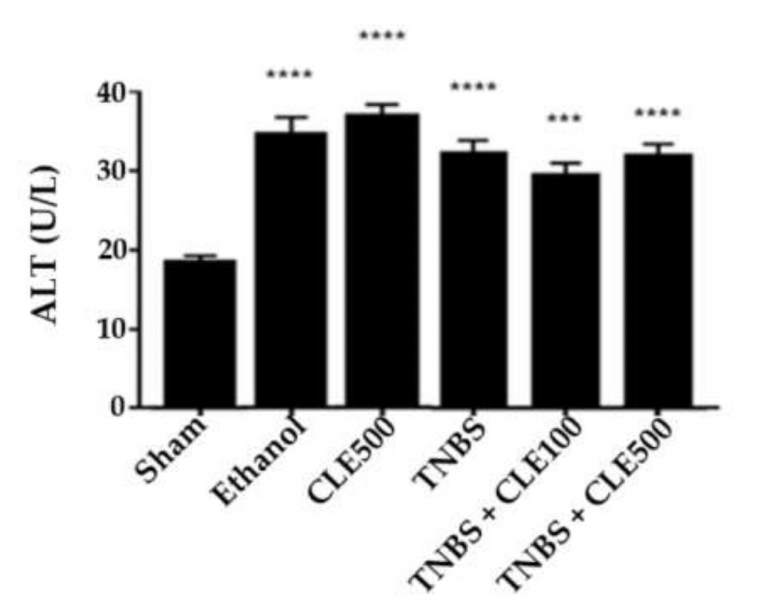
Figure 8. CLE influence on ALT levels in IBD context. Legend: One-way ANOVA and Tuckey’s post hoc test; *** p < 0.001, **** p < 0.0001, in comparison to the sham group. Abbreviations: ALT, alanine aminotransferase; CLE, C. cardunculus L. extract; TNBS, 2,4,6-trinitrobenzene sulfonic